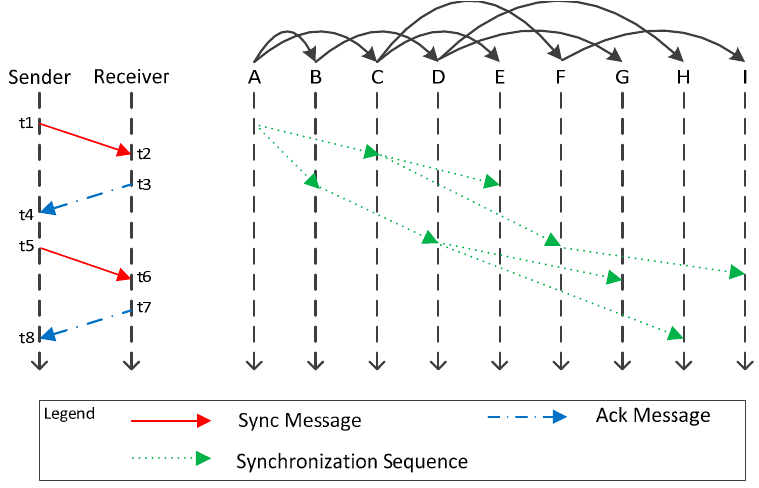
Figure 4. Base-station to base-station synchronization schematic.